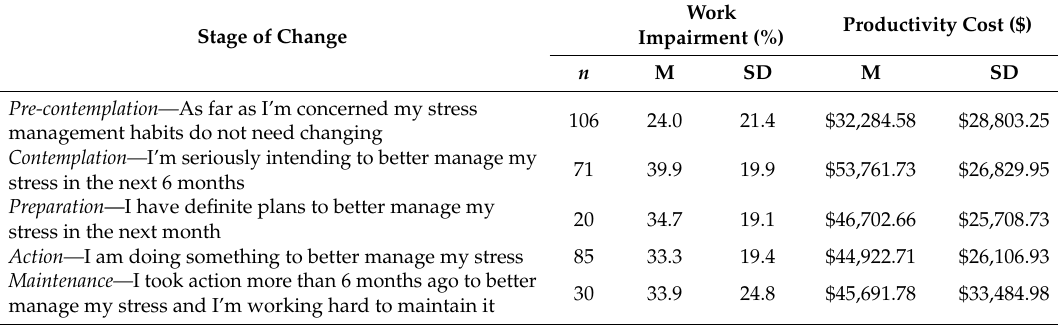
Table 4. Work impairment percentage and annual productivity cost per person based on stage of change. Stage of Change